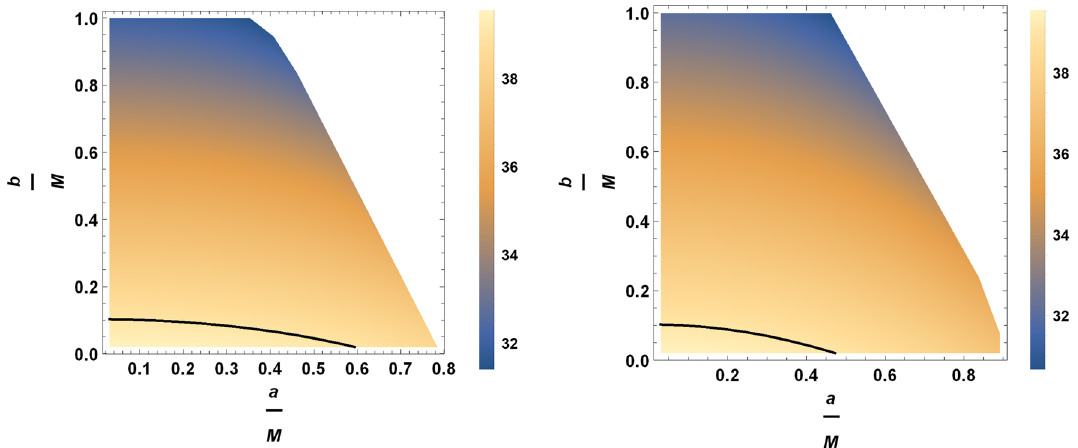
Fig. 22 The observable for angular diameter θ d as a function of black hole parameters. The left one is for l = 0 . 1, k = 0 . 1, and angle of inclination θ = 90 ◦ . The right one is for l = 0 . 1, k = 0 . 1, and θ = 17 ◦ . Black solid lines correspond to θ